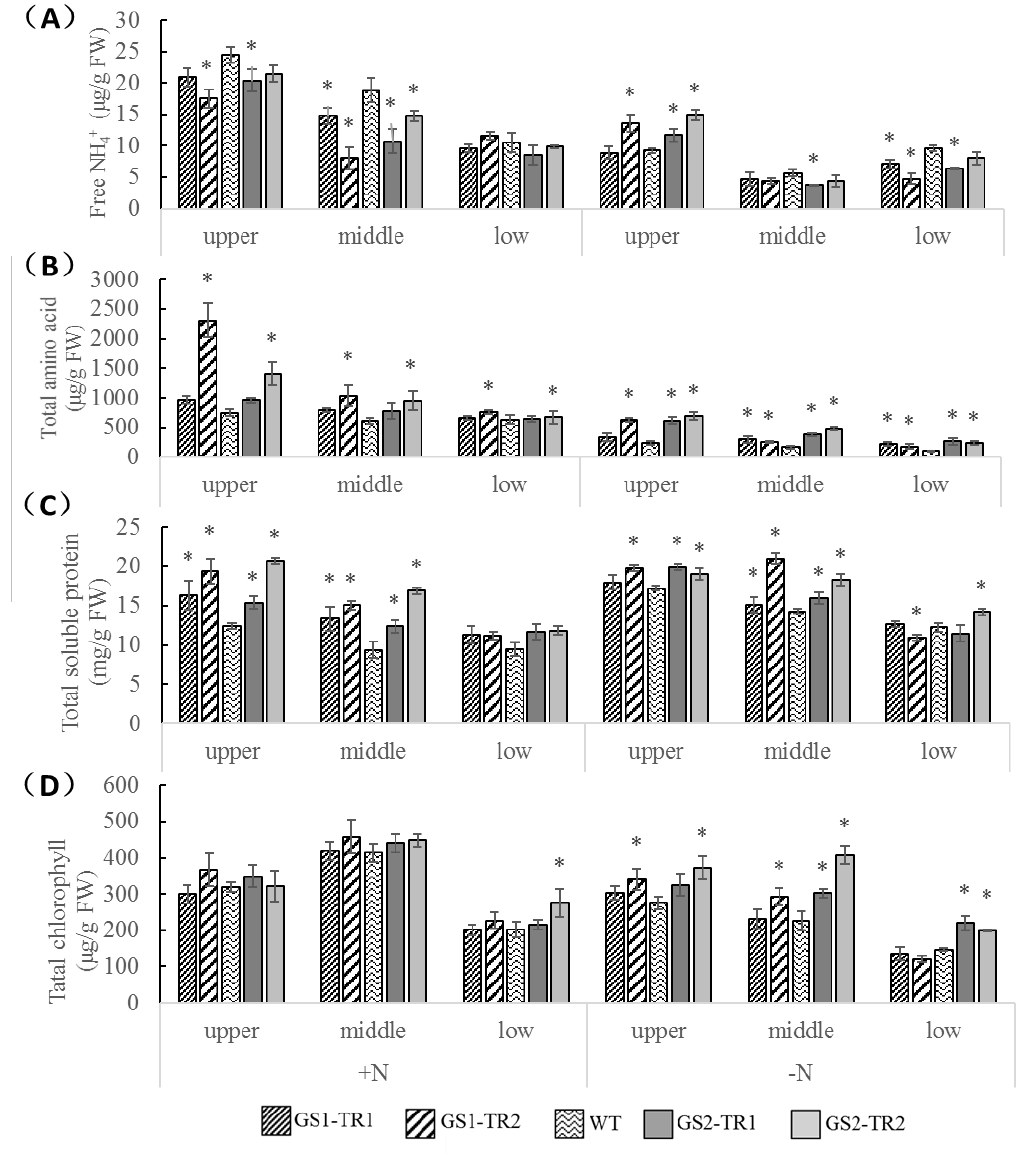
Figure 6. Nitrogen metabolite levels in the upper, middle, and lower leaves of GS1-TR, GS2-TR, and WT plants grown under nitrogen-sufficient and nitrogen-starvation conditions. The free NH 4 + ( A ), total free amino acid ( B ), total soluble protein ( C ) and total chlorophyll ( D ) content were determined. Each value is shown as the mean ± standard error of three replicates. Asterisks indicate that the date is significantly different ( p < 0.05) from the data of WT plants.